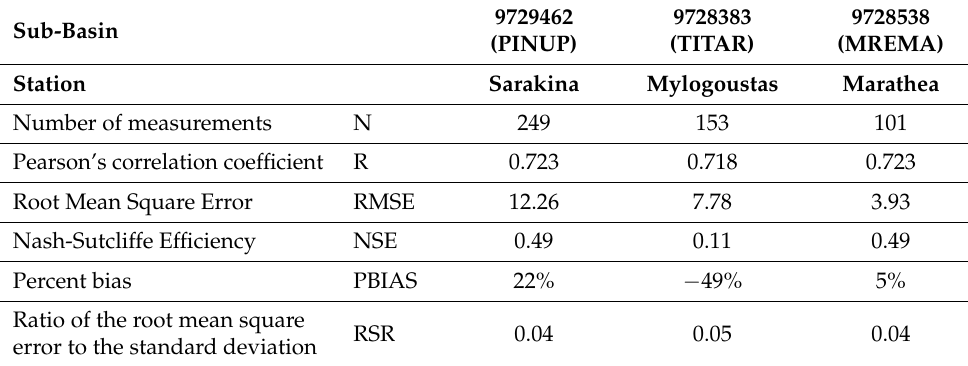
Table 3. Statistical characteristics and efficiency criteria for the evaluation of monthly discharges simulated by the hydrological model E-HYPE using measured